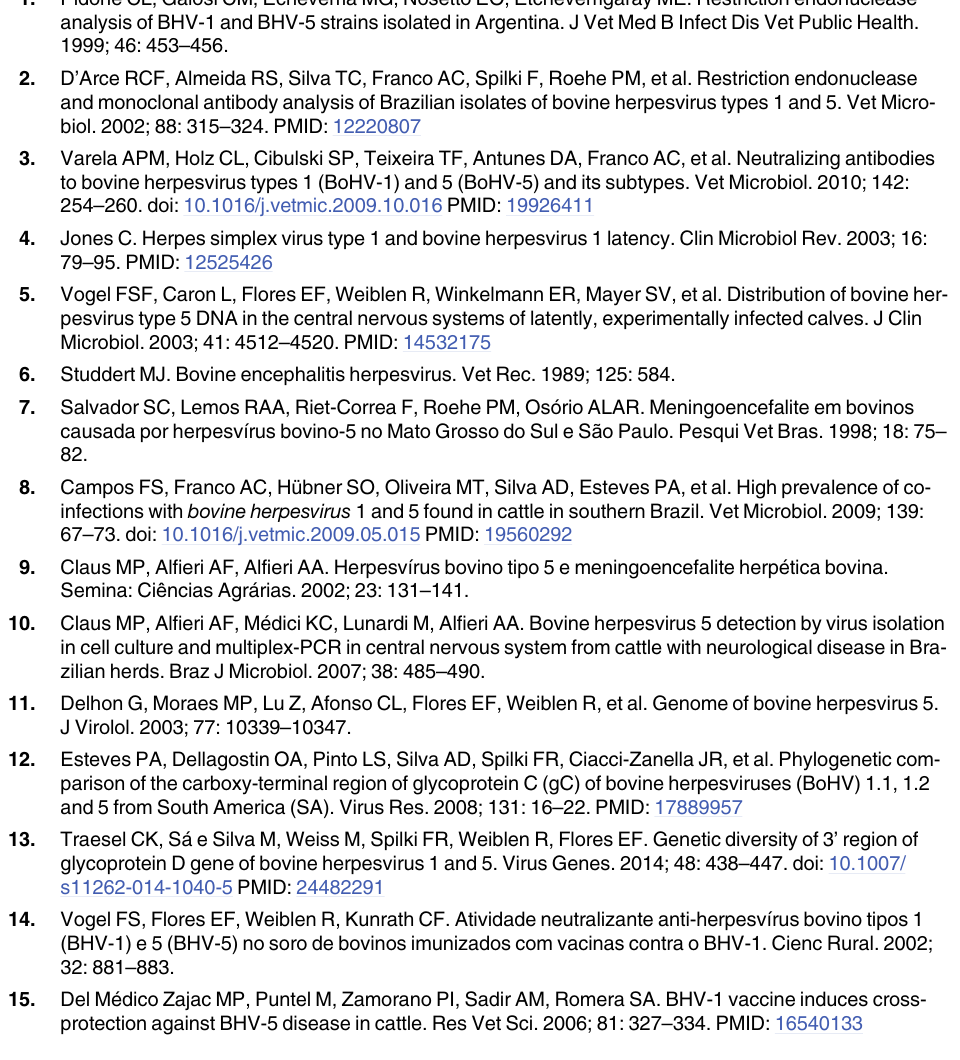
S2 Table. Comparative Evaluation Between Virus Neutralization Test (VNT) and the rgD5ELISA for the Detection of Antibodies to BoHV-5 in Vaccinated Cattle ( n = 8).